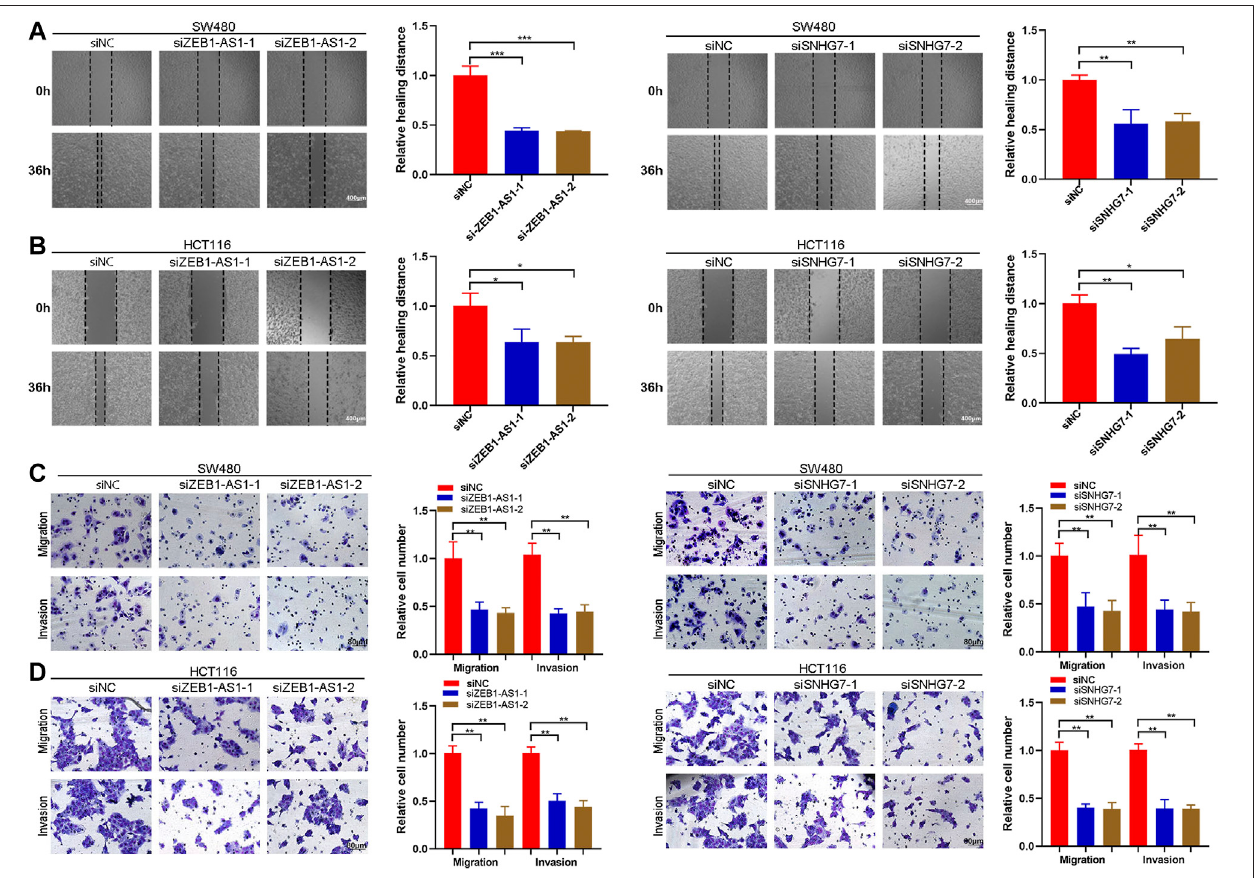
FIGURE 11 | ZEB1-AS1 and SNHG7 silencing inhibited the migration and invasion of CRC cells. (A,B) Wound healing assay showing that cell migration was signi fi cantly reduced after ZEB1-AS1 and SNHG7-siRNA transfection. (C,D) Transwell migration and invasion assays were performed, and the results suggested that migration and invasion were signi fi cantly reduced in ZEB1-AS1 and SNHG7-siRNA-transfected SW480 and HCT116